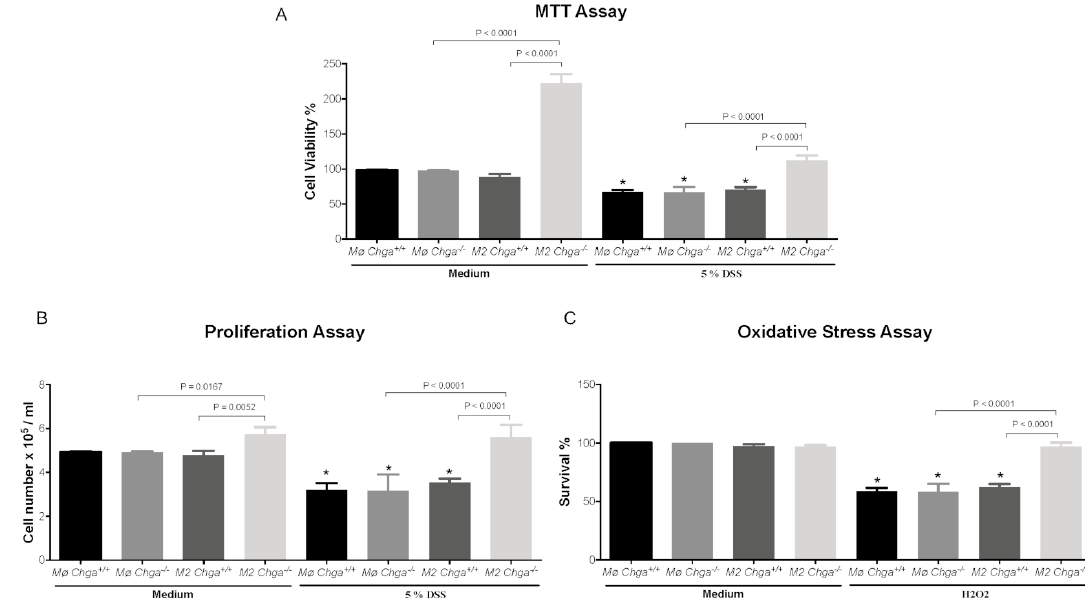
Figure 9. Chromogranin-A ( Chga )-deficient alternatively activated macrophages (M2)-conditioned supernatant maintains the functional properties of dextran sulphate sodium (DSS)-stimulated Caco-2 epithelial cells. Caco-2 cells were seeded at 3 × 10 5 cells / well onto tissue culture plates and treated with 2 mL of non-conditioned supernatant (Mo) or M2-conditioned supernatant of wild-type ( Chga +/+ ) and Chga -knockout ( Chga − / − ) for 24 h. Then cells were challenged with 5% DSS or regular medium for an additional 24 h. ( A ) intestinal epithelial cell viability (assessed by the 3-[4–dimethyl thiazolyl-2yl]-2, 5-diphenyl tetrazolium [MTT]), ( B ) proliferation, and ( C ) epithelial cells oxidative stress assay. One-way ANOVA followed by Tukey’s multiple comparison tests. Each value represents the mean ± SEM, n = 6. * p < 0.05 refers to significance compared with medium groups. Each experiment was repeated at least three times.